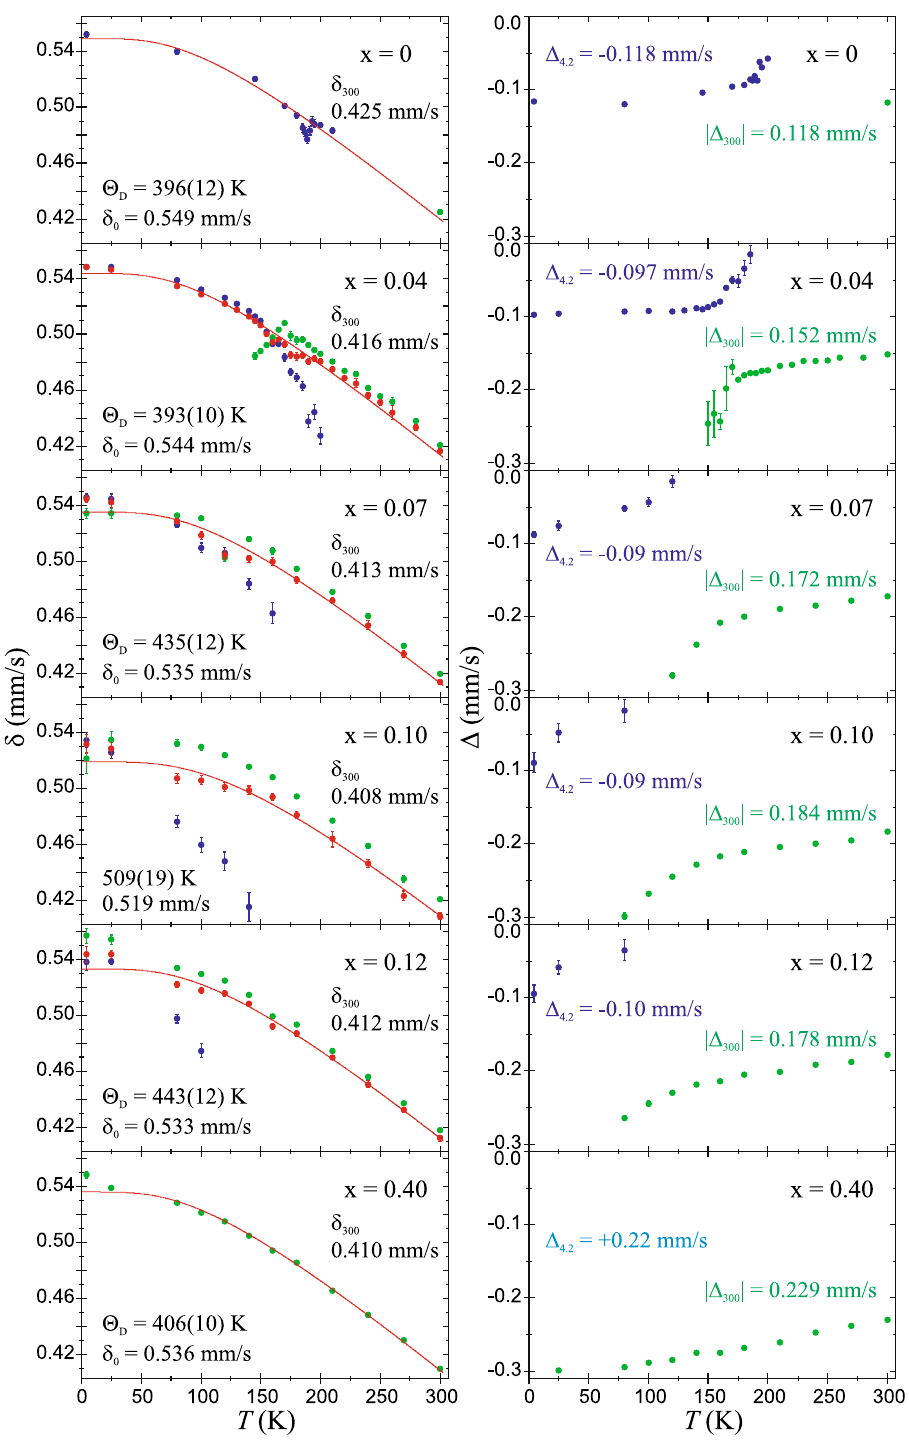
Figure 7. Temperature dependencies of the Mössbauer spectroscopy parameters: the spectral center shift δ relative to the shift of room temperature α-Fe, and the electric quadrupole splitting Δ. Values for the SDW spectral component and the second spectral component are shown in blue and in green, respectively. The weighted average spectral center shift < δ > is marked in red along with the solid lines representing the best-fit to experimental data using the Debye model for < δ > ( T ). The Debye temperature Θ D and the spectral shift at the ground state δ 0 are shown. The symbols δ 300 , Δ 4.2 and |Δ 300 | stand for measured values of the spectral shift, the quadrupole splitting, and the absolute value of the quadrupole splitting, at 4.2 K and 300 K, respectively. For x = 0.40, point of Δ 4.2 with the positive sign determined in presence of the Eu 2+ transferred hyperfine field isn’t shown. Note: for 57 Fe the sign of the quadrupole coupling constant cannot be determined without the hyperfine field or applied external magnetic